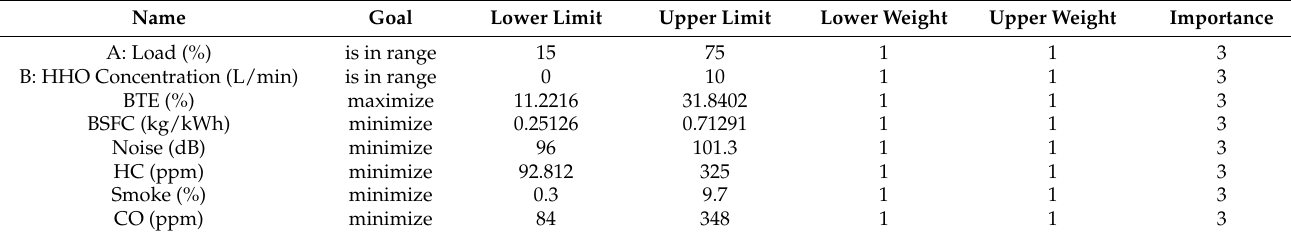
Table 15. Optimization setup.